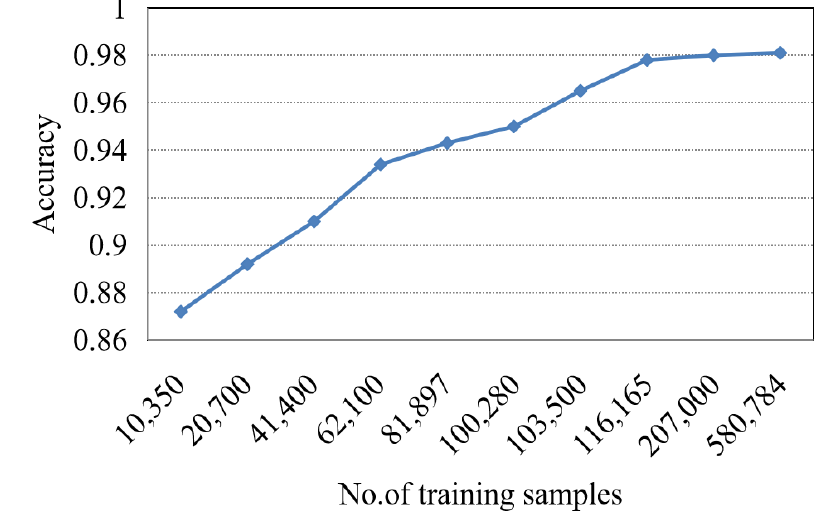
Figure 6. The recognition performance of different number of training